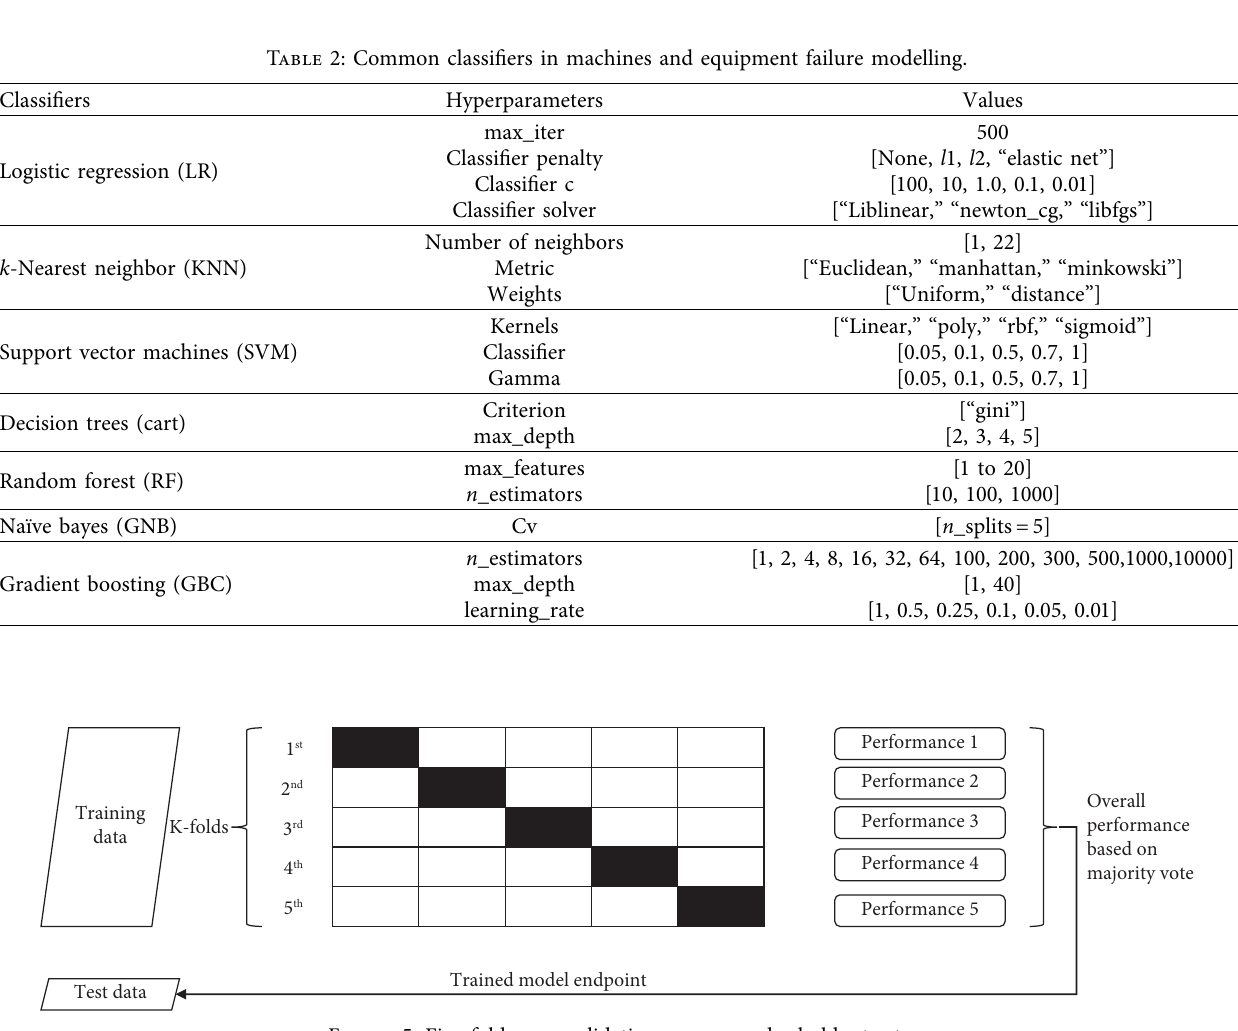
Figure 5: Five fold cross-validation process and a holdout